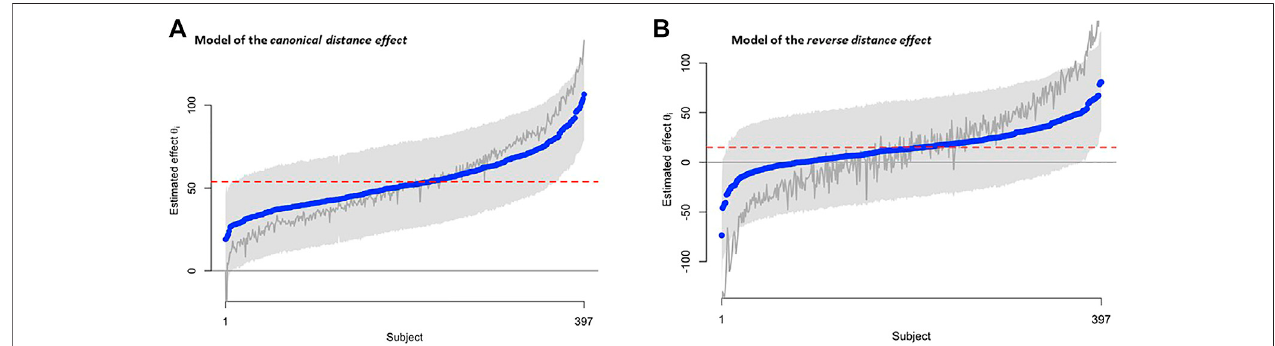
FIGURE 2 | Observed and estimated individual differences in (A) the canonical and (B) the reverse distance effect (in ms), ordered by observed effect size. Model- estimated effects (in blue) are derived from the positive-effect model (positive values) for the canonical distance effect and from the unconstrained model (positive and